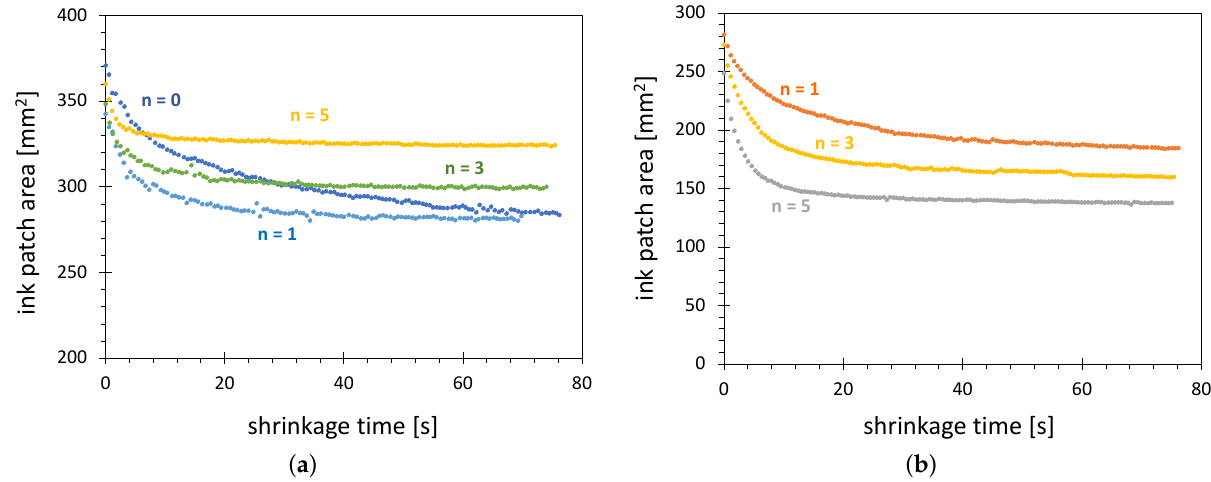
Figure 9. Shrinkage characteristics of the 58 mN/m test ink patches ( a ) directly after first ink application, after 1, 3 and 5 ink re-applications and ( b ) after 1, 3 and 5 ink wiping and renewed application. Treatment conducted in configuration D with the power of 4.5 W at the distance of 5